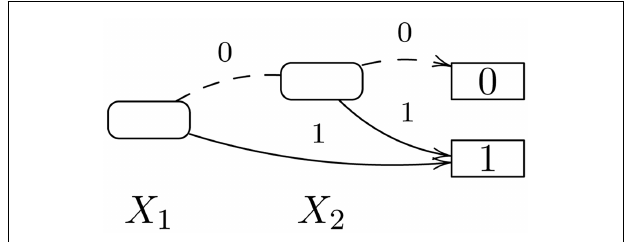
FIGURE 1 | Binary Decision Diagram for Example 1